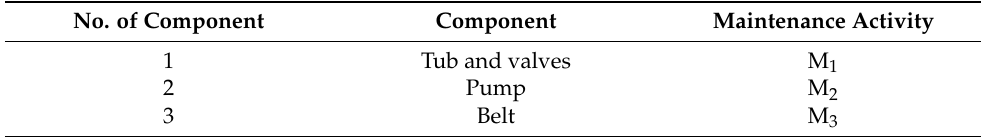
Table 6. For example, machine No. 1 is a fully automatic machine with a plastic drum. The maintenance activity (M 3 ) was performed on the belt in the first month then maintenance activity (M 2 ) was applied on a pump in the second month. However, this machine did not require any maintenance activity in the third, fourth, and fifth months. The time (T) between any two sequential activities is one month. Table 5. Components of washing machine and maintenance activities.